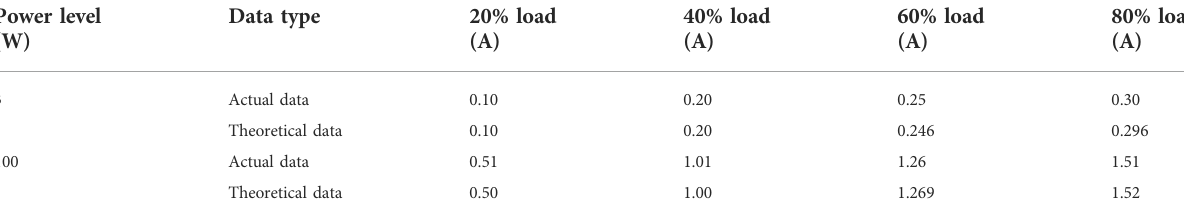
TABLE 5 Comparative between the theoretical value and the actual Value`` Power level